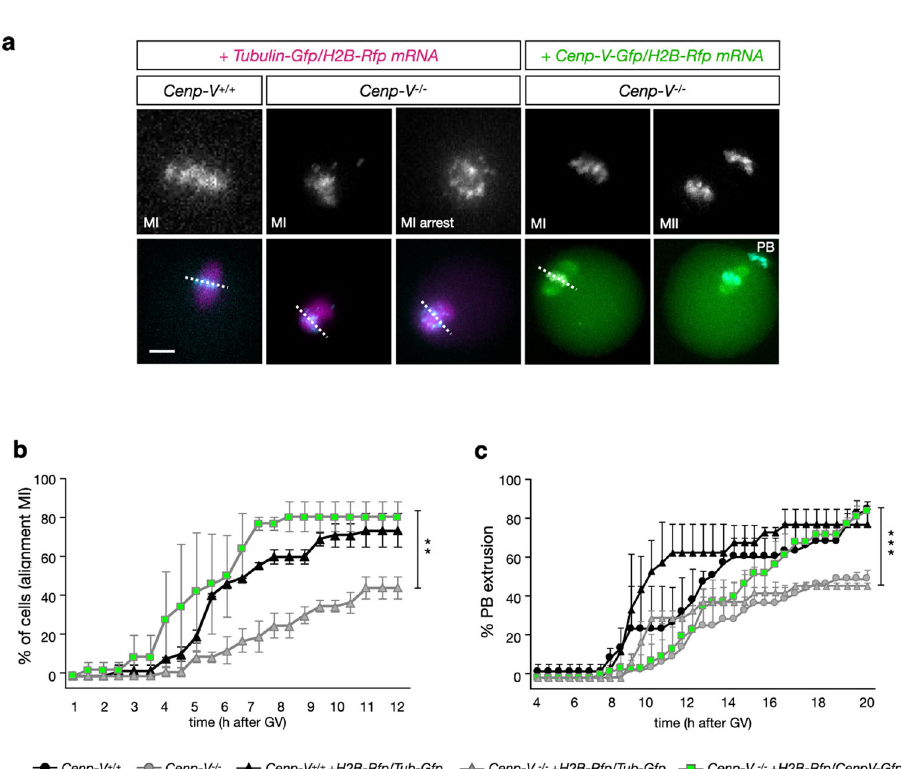
Fig. 3 Chromosome alignment is reduced and delayed in Cenp-V − / − oocytes. Polar body extrusion and chromosome alignment return to control values upon Cenp-V-Gfp mRNA injection. ( a ) Selected time frames from a time-lapse experiment showing progression through meiotic prophase until metaphase II in Cenp-V + / + and Cenp-V − / − oocytes expressing β -TUBULIN-GFP (magenta), H2B-RFP (cyan, large image in grey) and/or CENP-V-GFP (green) after mRNA injection. At 09:30h in metaphase I, the spindle is assembled and chromosomes are aligned in the equatorial plate (white dash line) in Cenp-V + / + compare to Cenp-V − / − oocyte. Note that Cenp-V − / − oocytes show normal chromosome alignment and extrude the PB only when expressing CENP-V-GFP. Oocytes were imaged after 4 h release from GV every 30 m. Maximum intensity projection is shown. See also supplementary Movies S2,S3,S4). Scale bar = 10 µ m. b Percentage of cells that show chromosome alignment overtime of the experiment shown in ( a ). in Cenp-V + / + and Cenp-V − / − oocytes. Quanti fi cation fi nishes before the fi rst polar body extrusion. Note that at 10h, 75 % of control oocytes have reached full chromosome alignment compared to the 35% of Cenp-V − / − oocytes, and only the injection of Cenp-V-Gfp (green square line) mRNA restores the values to the control. c Cumulative percentage of fi rst polar body extrusion overtime of the experiment shown in (a). Note that Cenp-V − / − oocytes properly extrude the PB only when expressing CENP-V- GFP (green square line) and not when expressing β -TUBULIN-GFP/H2B-RFP. See also supplementary movie S1. Statistic: ( b , c ) data were expressed as mean± SD and statistical differences were tested by a two way Anova test (*** p < 0.001, ** p < 0.01, * p < 0.05). The exact p values are available in the source data fi le. Statistical differences refer to the average of all data points. Anova test between Cenp-V + / + and Cenp-V + / + injected was not signi fi cant. Anova test between Cenp-V − / − and Cenp-V − / − β -Tubulin-Gfp/H2B-Rfp injected was not signi fi cant. n = 249 cells from 5 different old females. Thus, CENP-V de fi ciency reveals age-dependent weakening of the SAC in oocytes.